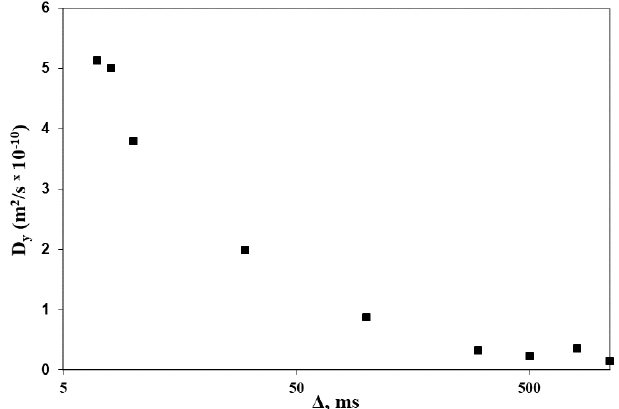
Figure 6. A dependence of the apparent diffusion coefficient in spruce wood on effective diffusion time Δ at orientation of the gradient in the tangential direction. Frequency is 400 MHz. Water content in the spruce wood is 0.62 g H 2 O / g dry mass. T= 298 K. Δ is presented in logarithmic scale.